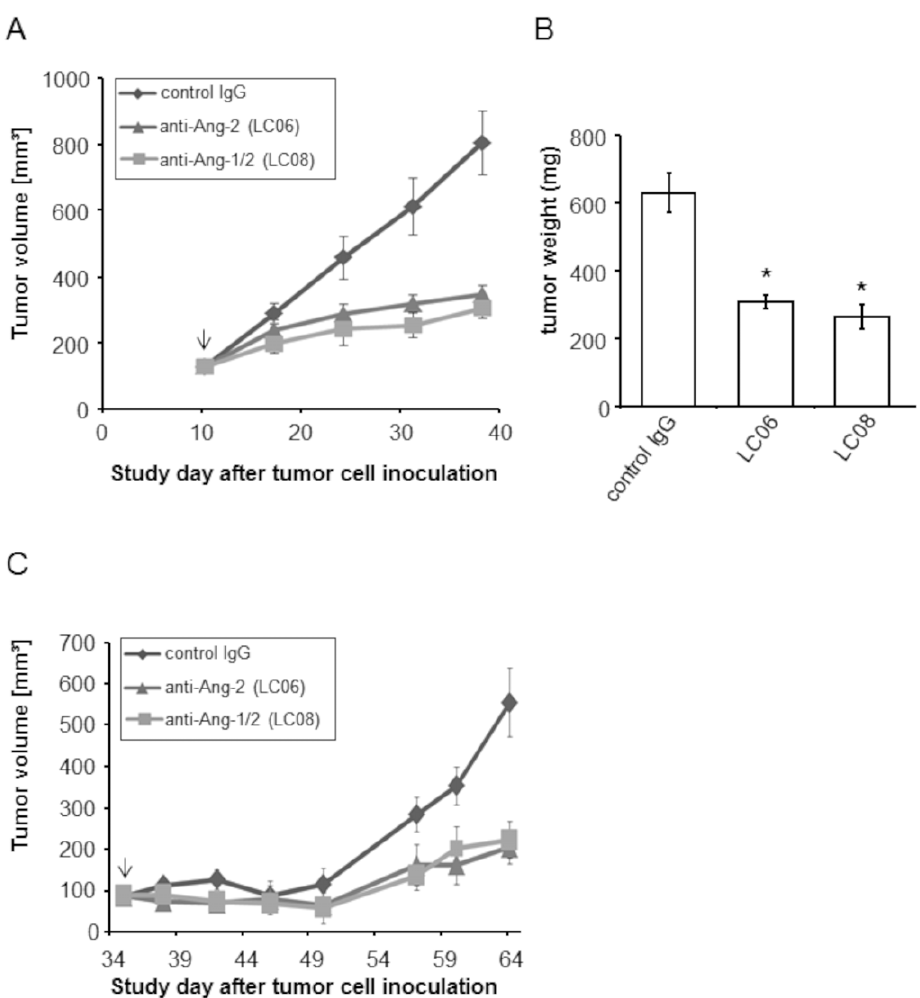
Figure 1. Anti-tumor activity of LC06 and LC08 in s.c. Colo205 and orthotopic KPL-4 xenograft tumors. ( A ) Colo205 tumor (mean 100 mm 3 ) growth curves in female SCID beige mice receiving LC06 and LC08 (10 mg/kg) once weekly i.p. (n=10, *p , 0.0001, Student’s t-test). ( B ) Total Colo205 tumor weight in tumor bearing mice treated with LC06 and LC08 (n=10, *p , 0.0001 compared to control, Student’s t-test). ( C ) KPL-4 orthotopic tumor (mean 90 mm 3 ) growth curves in mice receiving LC06 and LC08 (10 mg/kg) once weekly i.p. (n=10, *p , 0.05 compared to control, Student’s t-test). Error bars represent 6 SEM. Arrows indicate start of treatment. The results were confirmed in 3 independent experiments.